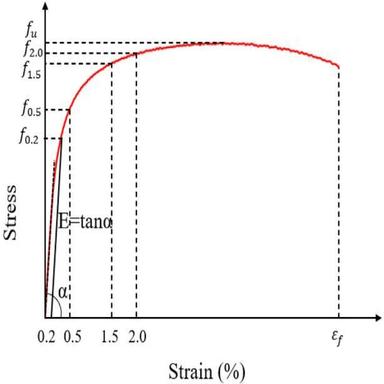
Definition of symbols used for the material properties.